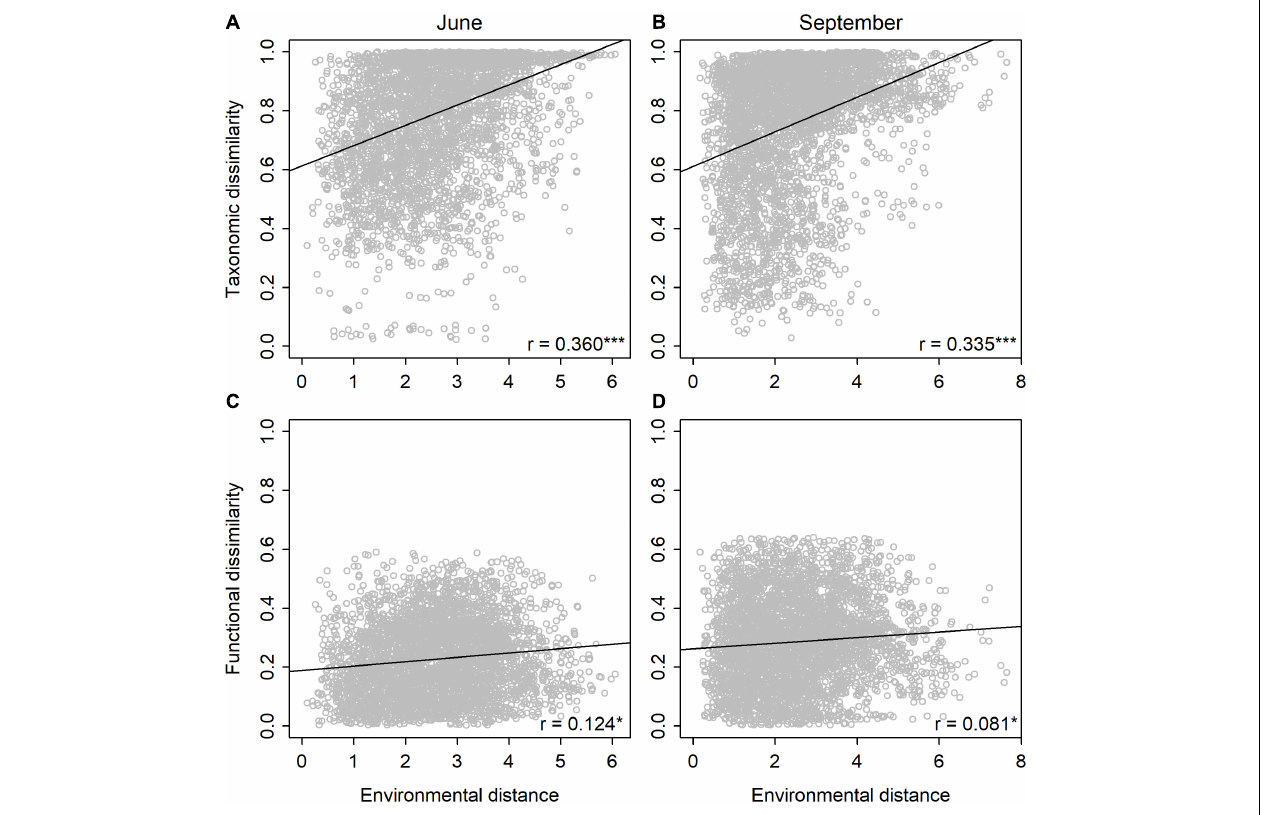
FIGURE 2 | Relationships between taxonomic community dissimilarity (Bray–Curtis) and environmental distance (Euclidean) in (A) June and (B) September, and between functional community dissimilarity (Bray–Curtis) and environmental distance (Euclidean) in (C) June and (D) September for diatoms among the rock pools ( n = 91). Shown are Mantel correlations and their statistical significances (* P < 0.05 and *** P < 0.001) and regression lines based on the linear